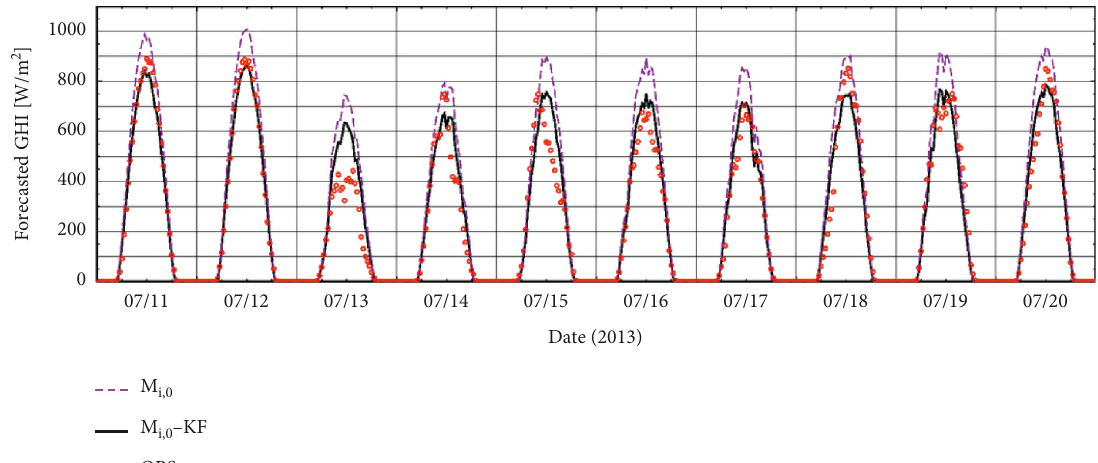
i, 0 , based on WRF and method